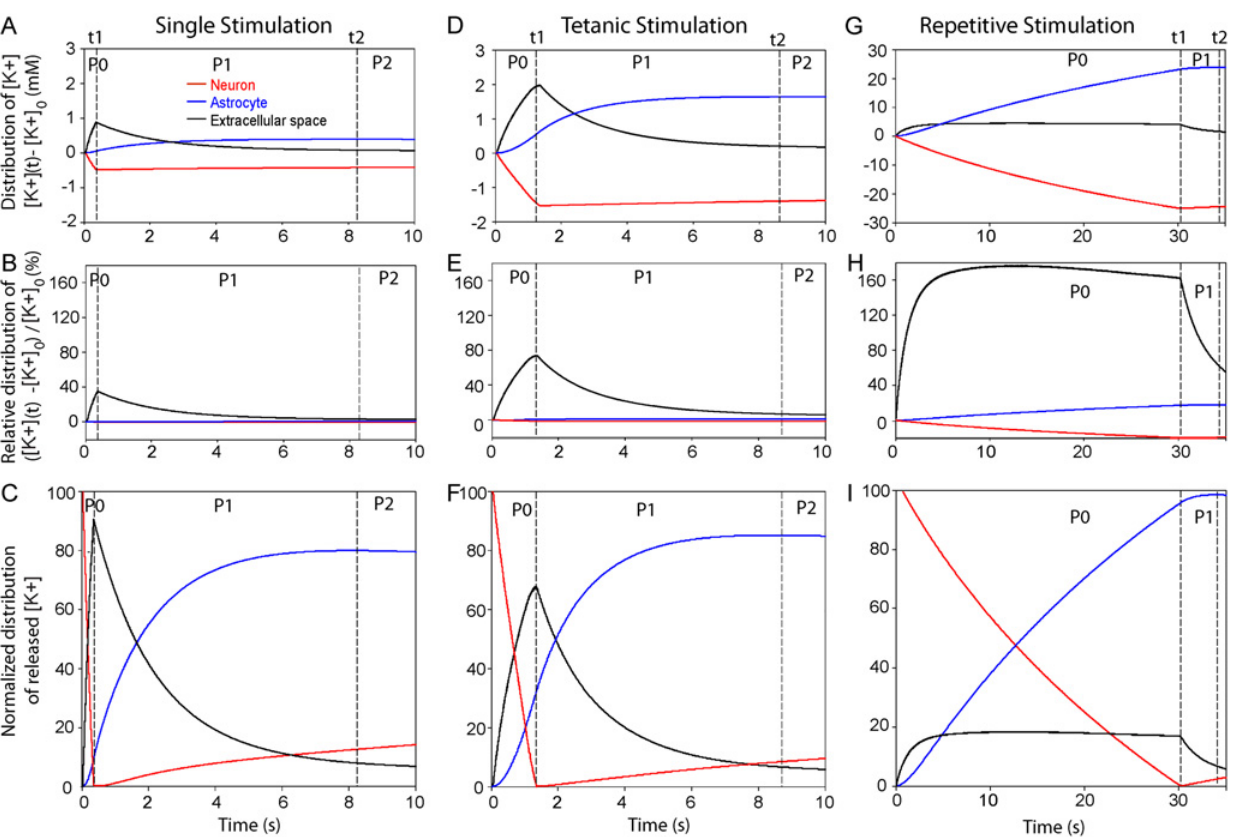
Fig 3. The potassium cycle between neuronal, astroglial and extracellular space compartments during basal and trains of stimulations. A-I , K + redistribution between neurons, extracellular space and astrocytes induced by single ( A-C ), tetanic (100 Hz, 1 s) ( D-F ) and repetitive (10 Hz, 30 s) ( G-I ) stimulations. For all regimes of activity, neuronal K + (red) is released, increasing K + in the extracellular space (black) during the stimulation initiated at time t = 0 (phase 0, t = 0 to t1), and is then cleared by the astrocyte (blue) (phase 1, t1 to t2). K + levels are illustrated for the different regimes in each compartment ( A , B , E , H ) or to the total amount of released K + by neurons ( C , F , I ). Finally, the buffered K + is slowly redistributed back to D , G ) and are normalized to basal [K + ] o ( neurons, which ends the K + cycle (phase 2, t2 to end). t1 represents the time point where neuronal release of K + stops, whereas t2 is the time point where astroglial K + uptake